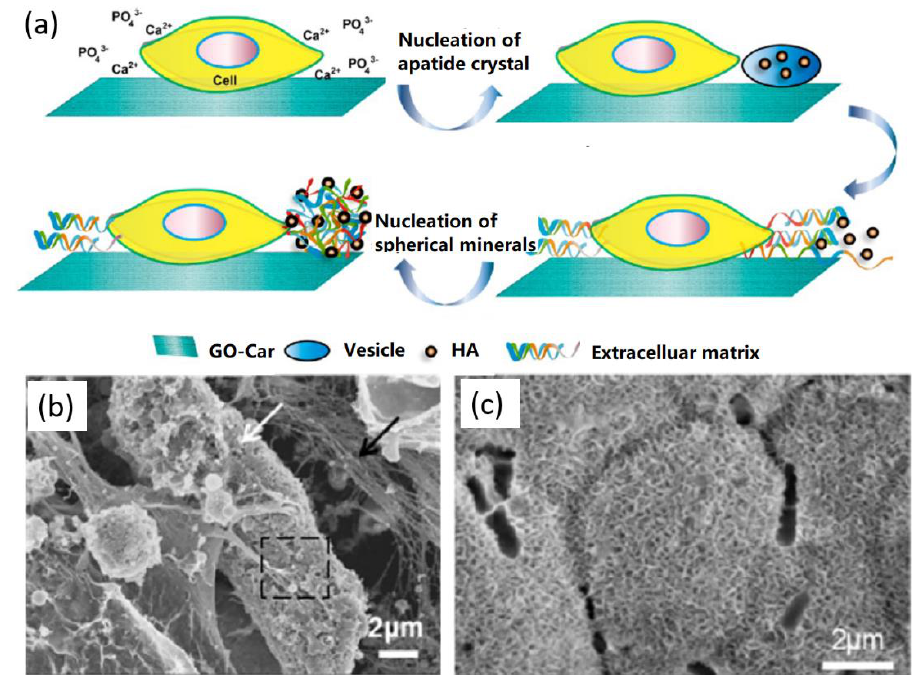
Figure 5. Cell-mediated biomimetic formation of HA on GO surface: ( a ) biomimetic formation mechanism of HA by cell. ( b , c ) Biomimetic synthesis of HA with 14 days mineralization of GO-Car ( b ) with and ( c ) without MC3T3-E1 cells. Reproduced with the permission from [59]. Copyright 2014 American Chemical Society.